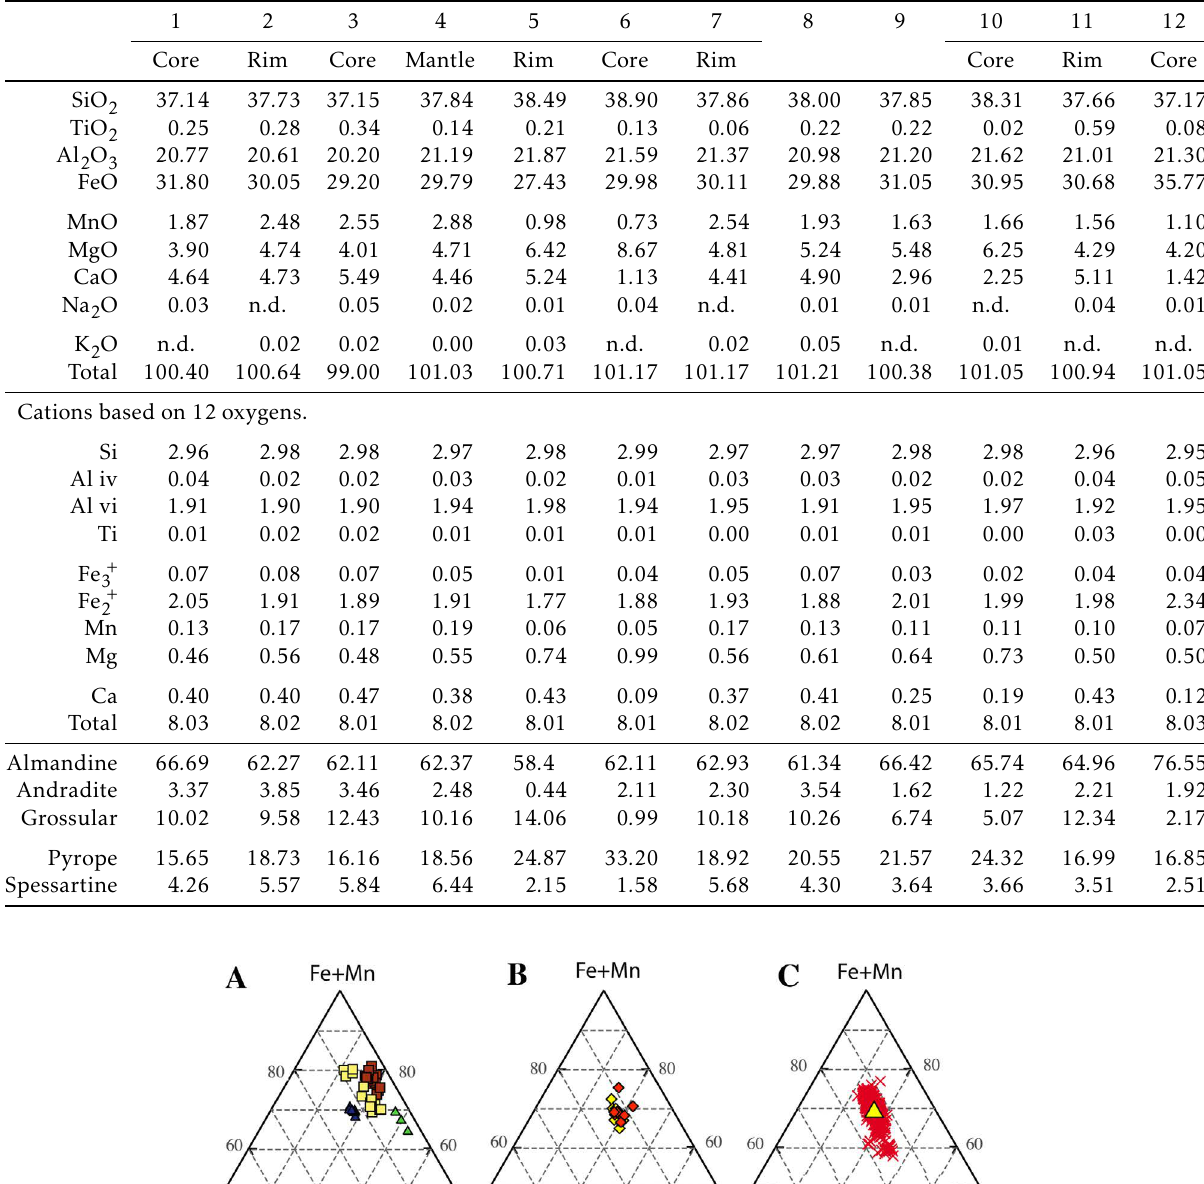
Table 6: Representative major element analyses of garnet crystals. n.d. = not detected (below detection limit). Cations based on 12 oxygens (apfu). Comments on occurrence: 1–2: garnet megacryst shown in Figure 10; 3– 4: garnet megacryst shown in Figure 6D; 5: euhedral garnet shown in Figure 2B; 6–7: garnet from the garnetite